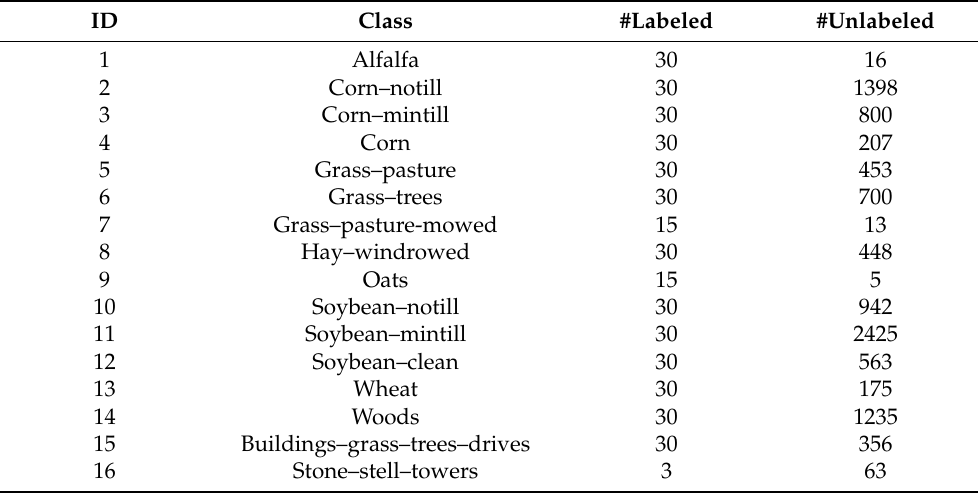
Table 8. Indian Pines dataset samples